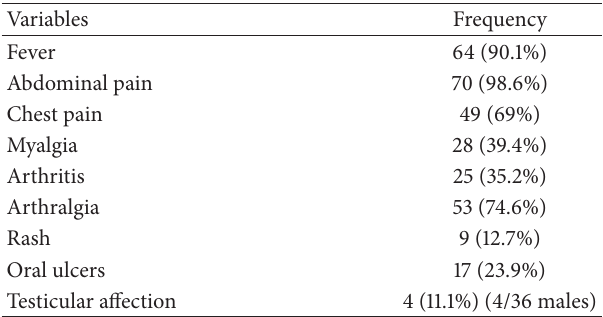
Table 1: Clinical characteristics of the studied FMF patients during the FMF